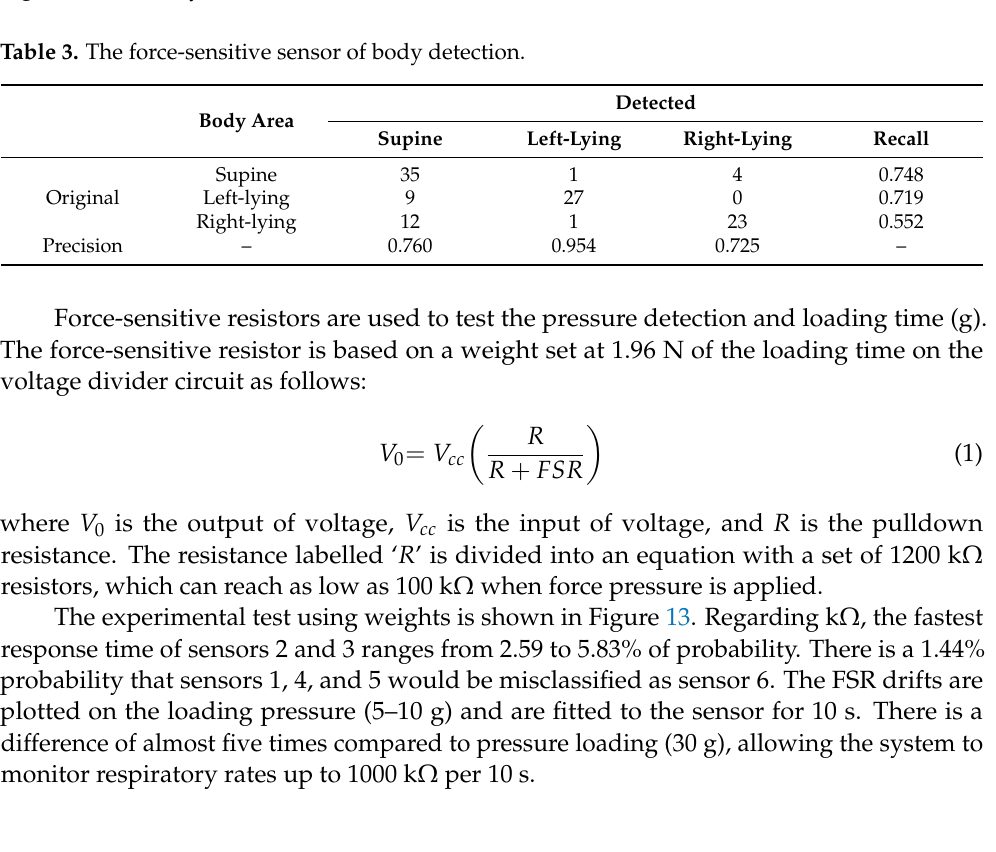
Figure 13. Pressure sensor response test.